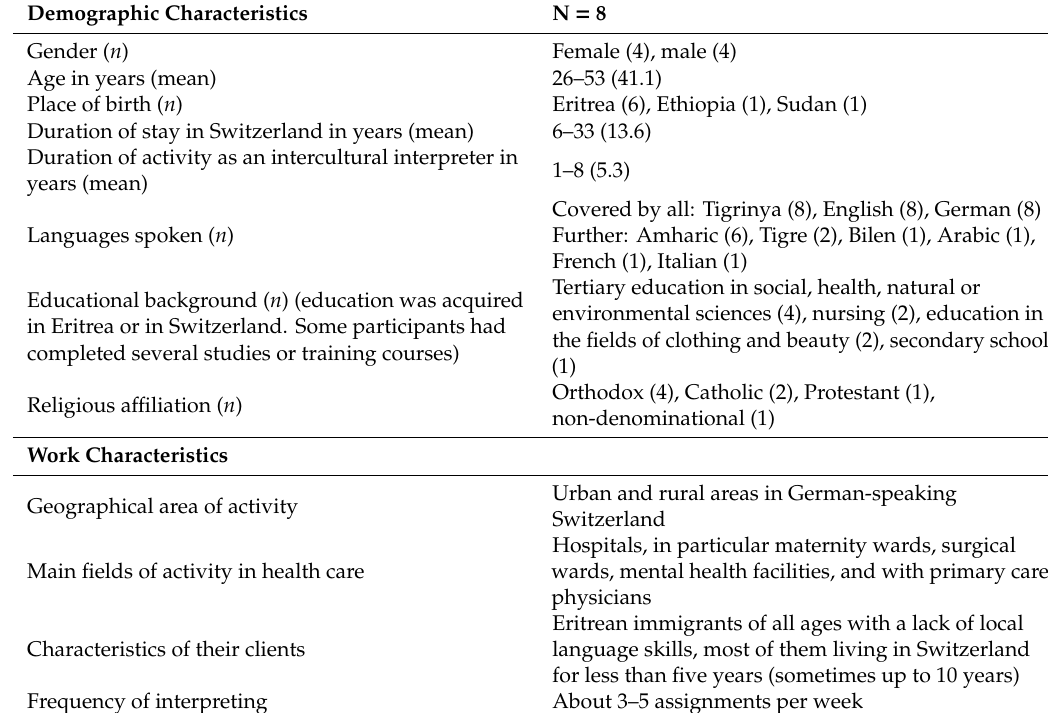
Table 1. Demographic and work characteristics of the